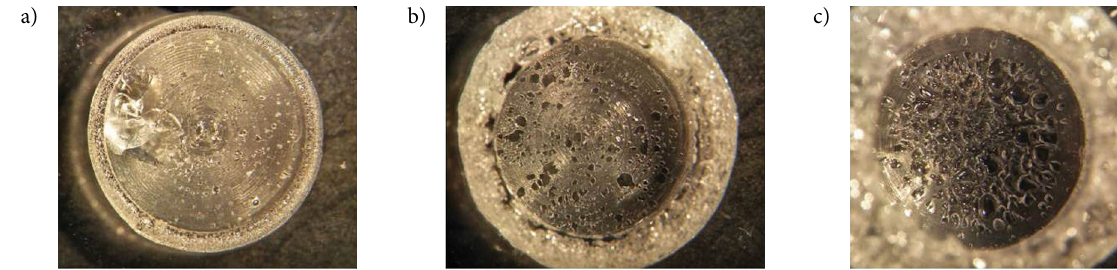
Fig. 8. Different degrees of bubble formation during the process (source: own photos): a – t h = 3 s; b – t h = 5 s; c – t h = 7 s